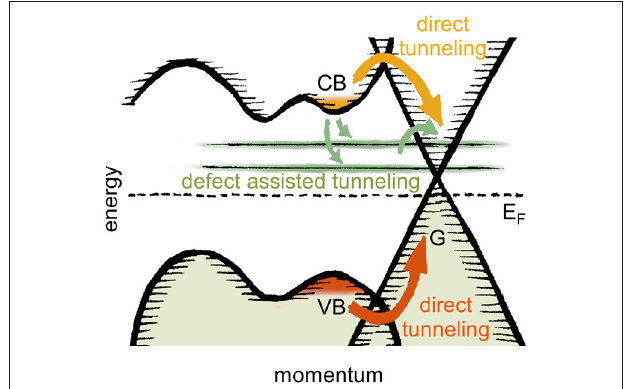
FIGURE 6 | Sketch of microscopic charge transfer model. Thick yellow and red arrows indicate direct tunneling of electrons and holes, respectively, through the crossing points of the respective bands. Green arrows indicate defect-assisted tunneling of electrons via S vacancies inside the WS 2